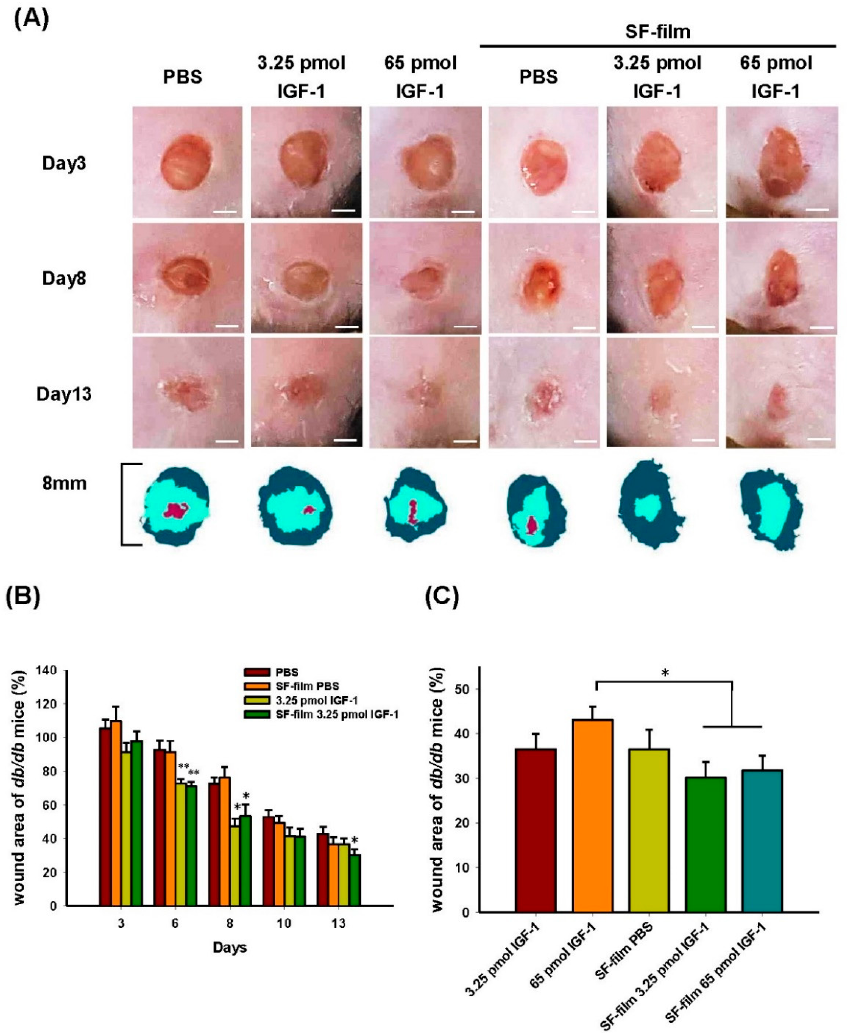
Figure 7. Analysis of diabetic wound healing treated with different SF-films. ( A ) Images of the wound area from day 0 to 13 post-wounding; scale bars = 5 mm. Wound closure boundaries at days 0 (dark green) and 13 (light green) and unhealed tissue at day 13 (red) are overlaid at the bottom. ( B ) Quantification of wound closure upon different treatments. Statistically significant differences between PBS and other treatments were determined by Dunnett’s multiple comparison post hoc test. * p < 0.05 and ** p < 0.01; n = 5; all error bars represent the standard error of the mean. ( C ) Quantification of the wound area at day 13 post-wounding after different treatments. Five